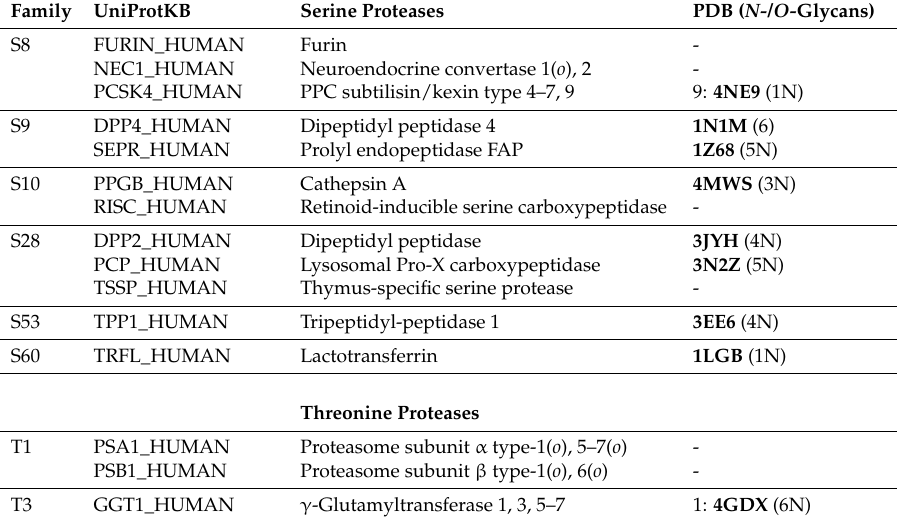
Table 4. Glycosylated human serine and threonine proteases ( o : O -glycans). Included are families